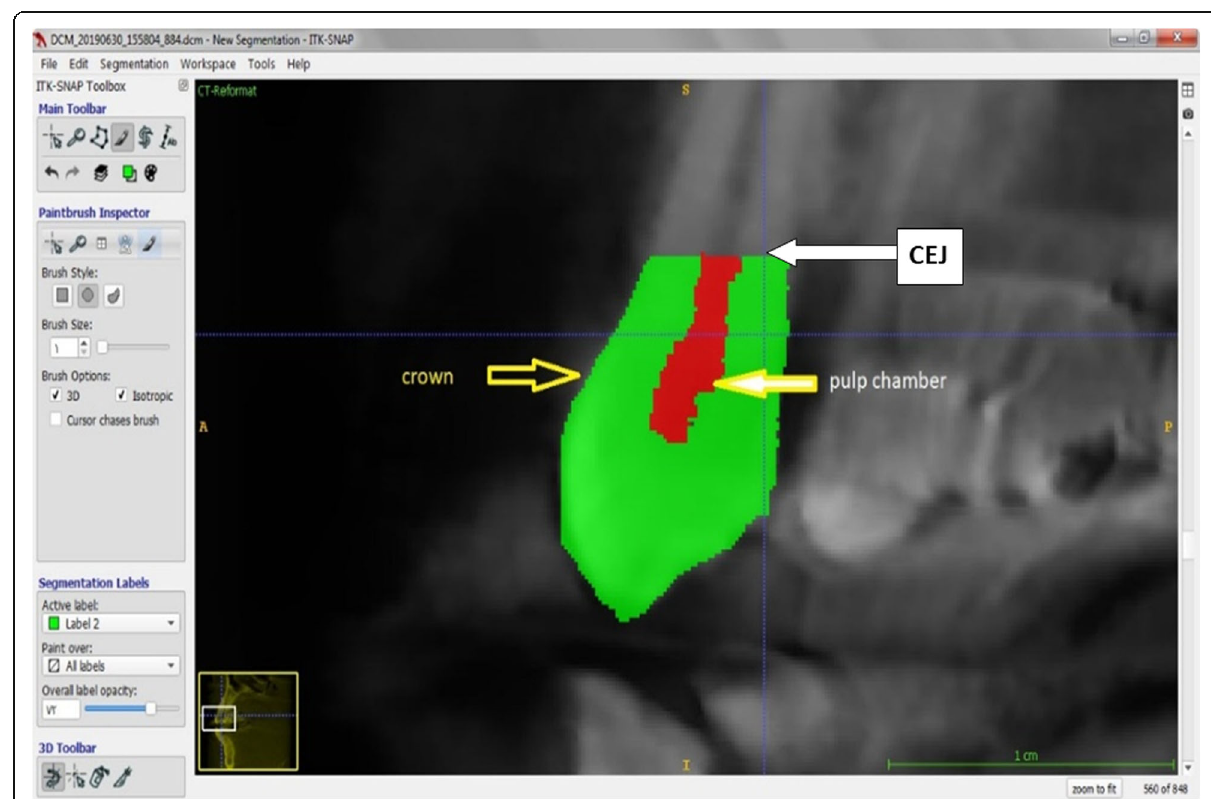
Fig. 2 Canine pulp chamber (red) and crown (green) with sharp demarcation and both ended at the cemento-enamel junction (CEJ) through a cross-sectional